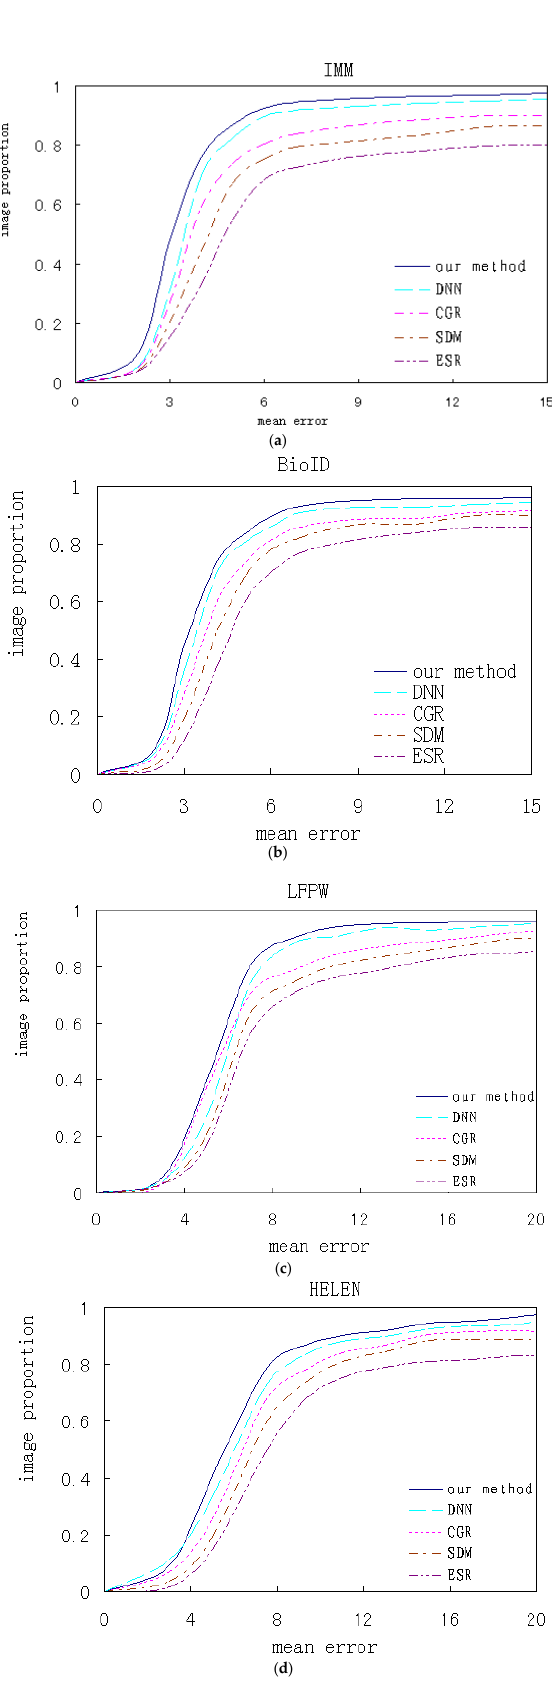
Figure 18. The algorithms performance comparison on the different databases. ( a ) IMM; ( b ) BioID; ( c ) LFPW; ( d ) HELEN.